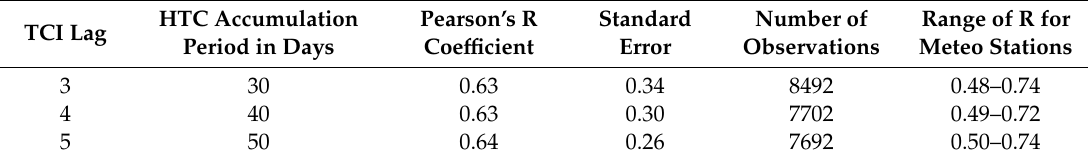
Table 2. Results of multivariate regression (Equation (4)) in three versions of HTC accumulation (i.e., 30, 40, and 50 days) for agricultural area